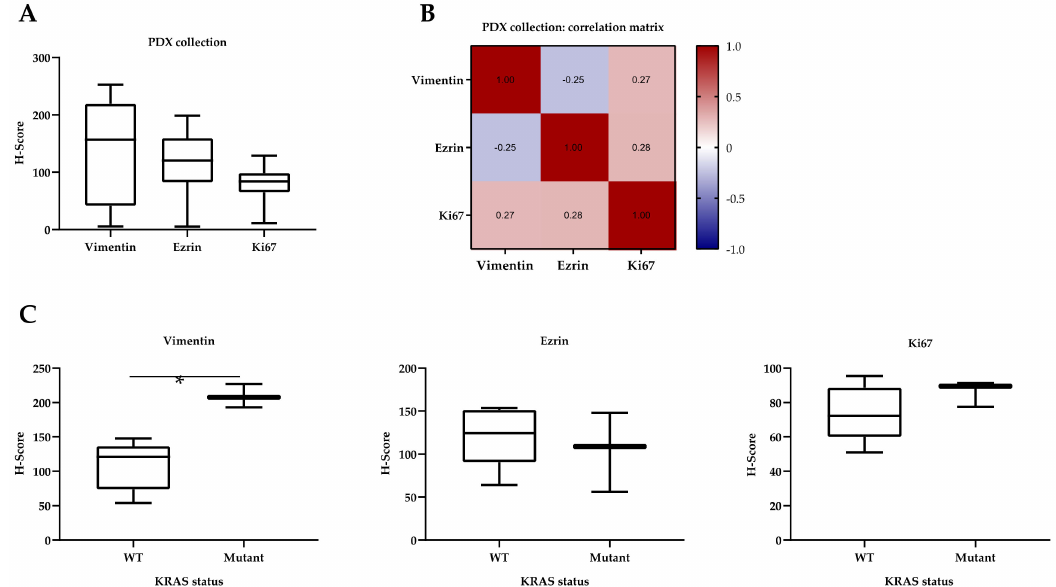
Figure 5. Expression of vimentin, ezrin, and Ki67 proteins in the PDX tumors. H-score analysis was used to compare the expression of proteins involved in EMT (vimentin, ezrin) and cell proliferation (Ki67) between PDX tumors. ( A ) Box and whisker plots for the H-scores of every protein in the primary tumor and the X0 to X2 passages of all PDX tumors from the 8-PDX-NSCLC collection. ( B ) Correlation matrix obtained from applying Spearman’s rank correlation coefficient to all the H-scores ( n = 32 per protein) by pairs of proteins. ( C ) Mann–Whitney test (MW) comparison of vimentin, ezrin, and Ki67 expression with KRAS mutational status. WT: wild type; mutant: KRAS p.G12C. Coefficients are shown inside every comparison square. *: p -value <